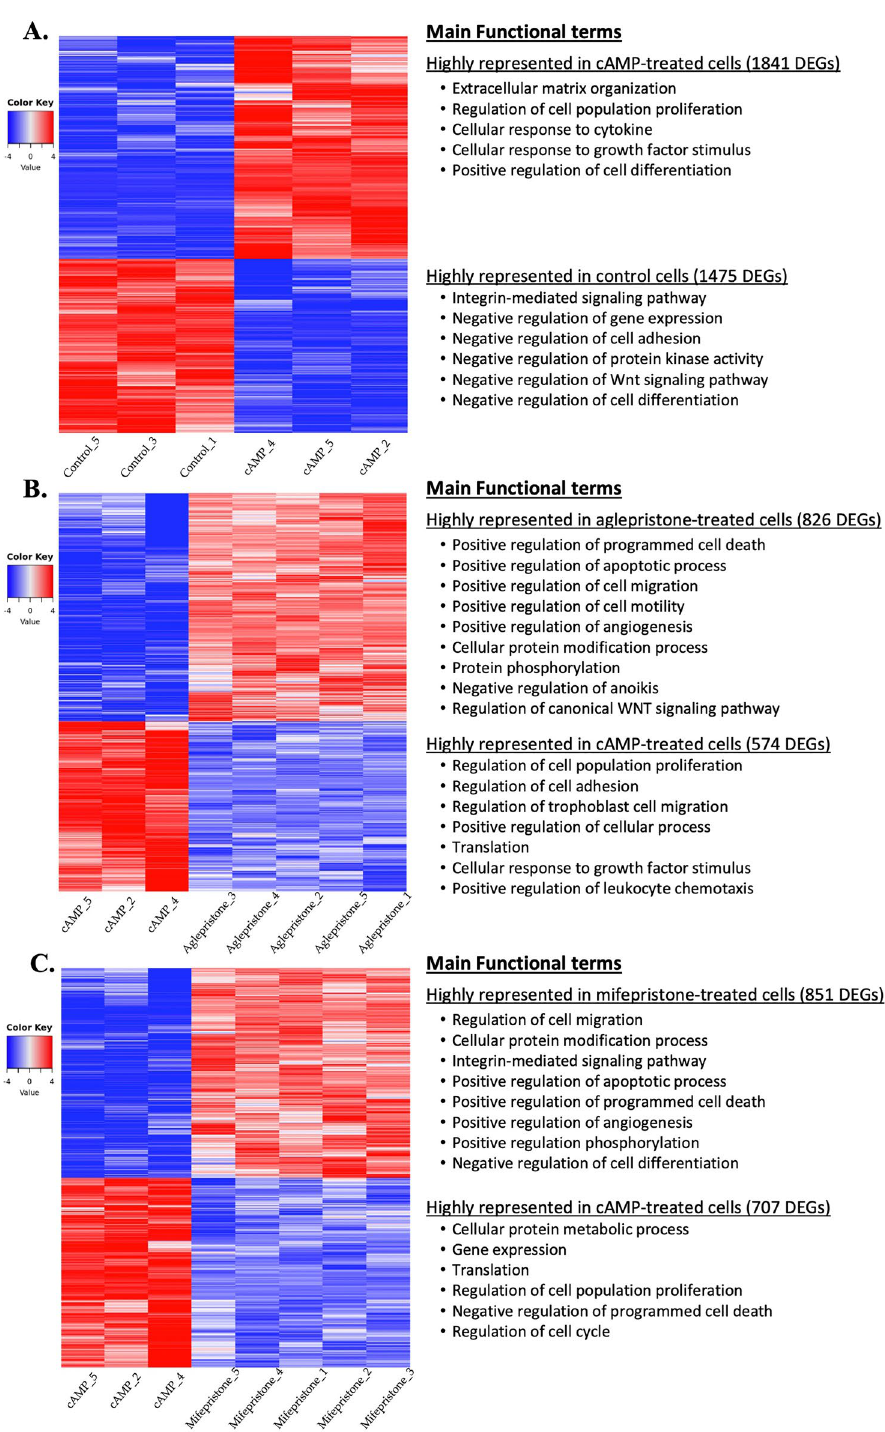
Figure 2. Heatmap and overrepresented gene ontologies in differentially expressed genes (DEGs) induced by different treatments ( P < 0.01, FDR < 0.01). Gradient of expression of each gene, relative to its abundance, is represented by the colors red and blue. The main overrepresented biological process gene ontologies identified with EnrichR are listed for each contrast. The entire list of DEGs and statistical details for all contrasts are provided in the Supplementary Files 1 and 2. ( A ) Heatmap of 3316 DEGs of the contrast “cAMP versus control”. 1841 genes were more, and 1475 genes were less expressed after in vitro decidualization. ( B ) Heatmap of 1400 DEGs of the contrast “aglepristone versus cAMP”; 826 genes were more, and 574 genes were less expressed following aglepristone treatment. ( C ) Heatmap of 1558 DEGs of the contrast “mifepristone versus cAMP”; 851 genes were more, and 707 genes were less expressed following mifepristone